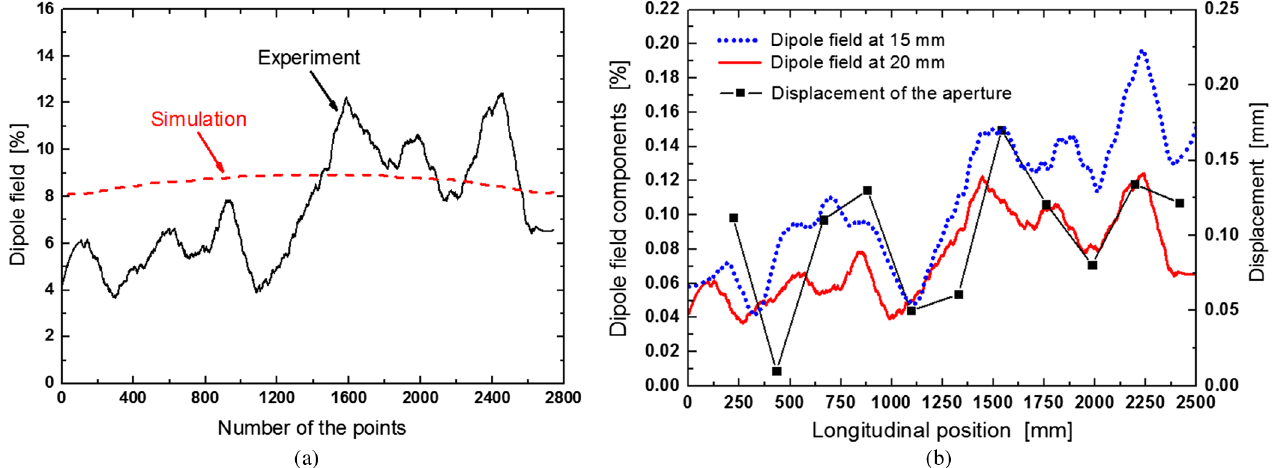
FIG. 19. The ratio representing the dipole field